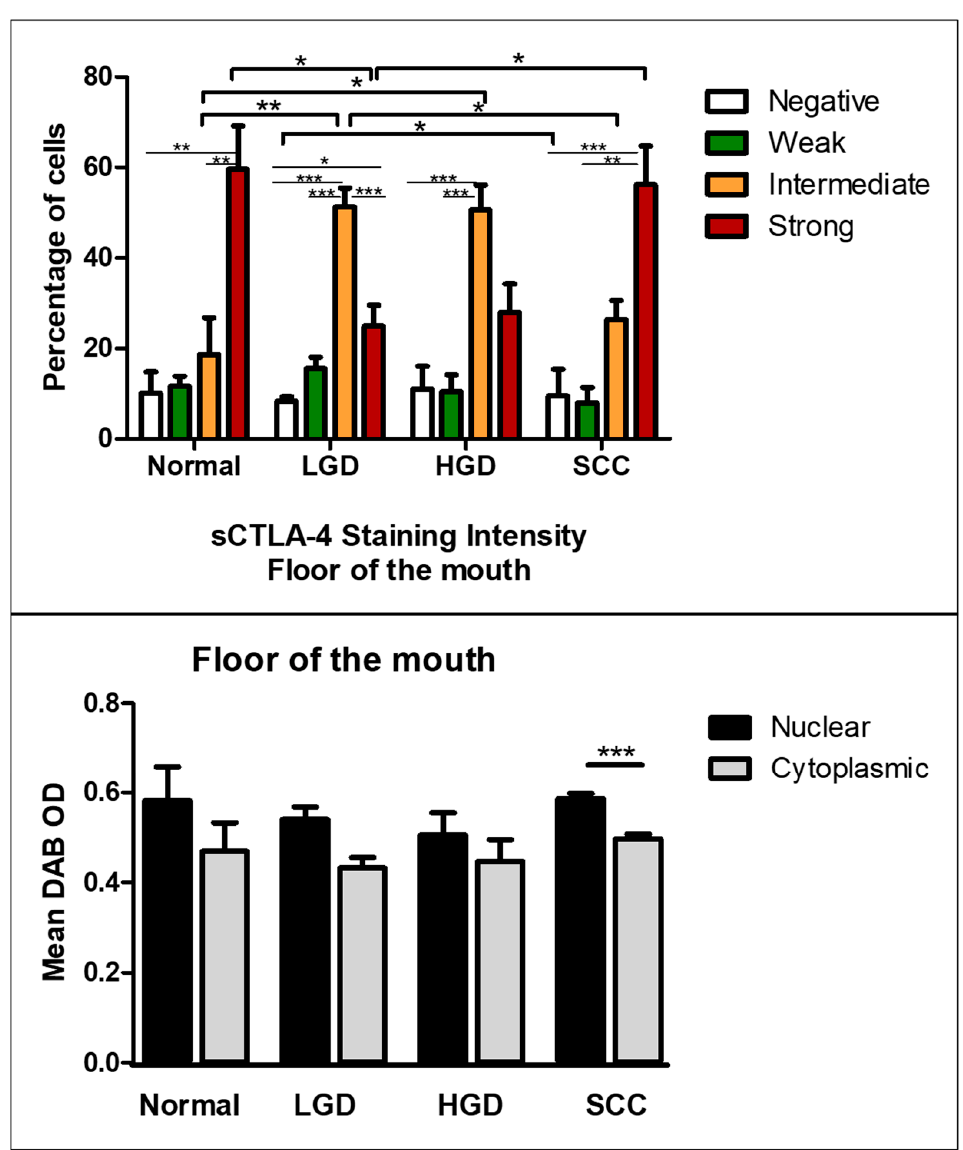
Figure 2. Quantification of the staining intensity in normal, low-grade dysplasia (LGD), high-grade dysplasia (HGD), and squamous cell carcinoma (SCC) from the floor of the mouth. The upper panel compares different staining intensities (negative, weak, intermediate, and strong) within each diagnostic group and between different diagnostic groups using Kruskal-Wallis with post hoc Dunn’s tests. Lower panel compares the mean DAB OD, representing sCTLA-4 between the nucleus and the cytoplasm in each of the diagnostic groups in all the cells, t-test. The number of images analysed for the top panel per group: normal = 10, LGD = 28, HGD = 13, and SCC = 12. Number of cells analysed in the lower panel per group: normal = 32,197 cells from five images, LGD = 40,510 from four images, HGD = 54,683 from five images, and SCC = 186,131 cells from six images. Error bars represent the standard error of the mean. * p < 0.05, ** p < 0.01, *** p < 0.001. When comparing the mean DAB OD between the nucleus and cytoplasm for all the diagnostic groups and all the staining intensities (not shown), the nucleus stained more strongly than the cytoplasm, similar to what was observed in HNC cell lines (Figure 2 and Supplemental Figure S5). The biggest differences between nuclear and cytoplasmic